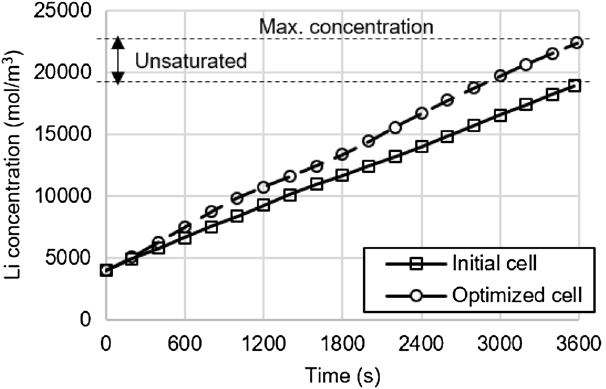
Figure 7. Variation of Li concentration in the solid phase of cathode for initial and optimized cells during 1C discharge.